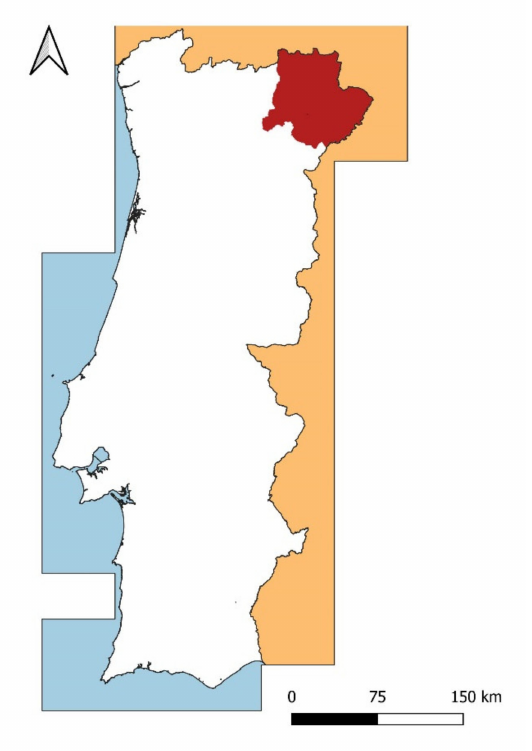
Figure 1. Location of the study area, the Nordeste region (in red), in Portugal (in